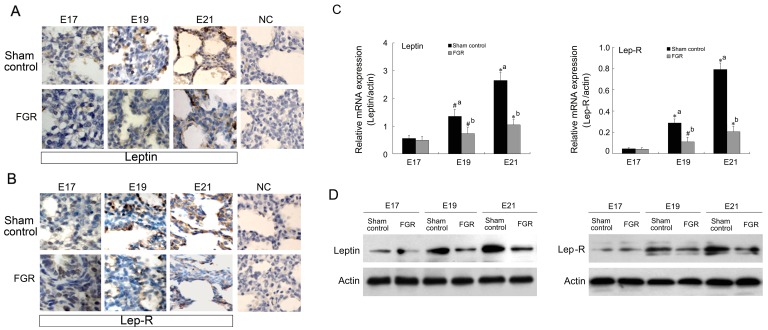
Expression of leptin and Lep-R in fetal lungs of the FGR rat.A and B: Leptin (A) and Lep-R (B) in fetal lungs at embryonic day 17 (E17), day 19 (E19) and day 21 (E21) were determined by immunohistochemical staining (×400). NC: the negative control. C: Fetal lung tissue from different stages of FGR rats was collected, and total RNA was extracted for mRNA expression measurement of leptin (right) and Lep-R (left) by quantitative real-time RT-PCR. *P<0.01, #P<0.05; a: vs E17 sham group, b: vs the corresponding sham group (n = 3). D: Fetal lung tissue isolated from different stages of FGR and sham control rats were subjected to western blot analysis to determine the protein levels of leptin and leptin receptor. All data were shown as means of three independent experiments.